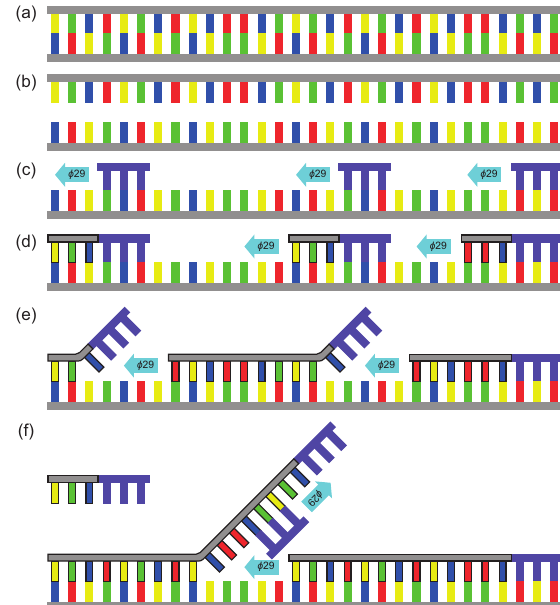
Figure 1. Schematic representation of the MDA reaction. In panel ( a ), a dsDNA strand is shown. In panel ( b ), denaturation happens at 95 ◦ C. In panel ( c ), the random hexamer-primers (purple) and φ 29 DNA polymerase (blue arrow) bind to the initiation sites. In panel ( d ), the amplification is performed by the polymerase, which binds complementary bases to the ssDNA strand. In panel ( e ), the polymerase encounters another hexamer binded to an initiation site and starts lifting up this hexamer. In panel ( f ), a hexamer binds to the displaced ssDNA strands and the polymerase starts the amplification from this initiation site. For clarity, the amplified DNA is bordered with